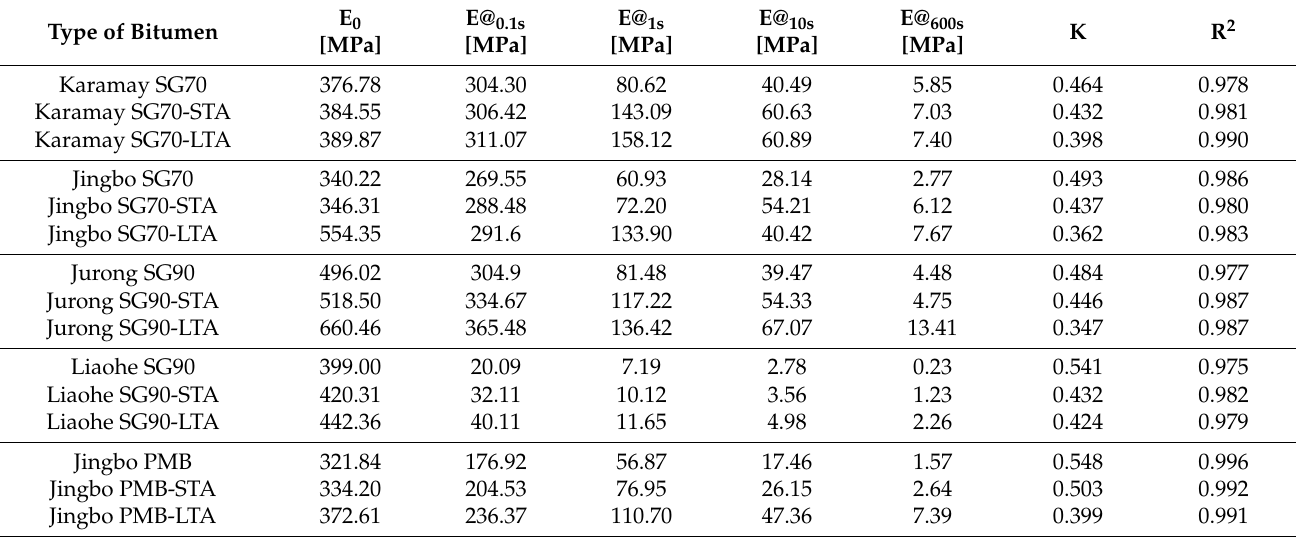
Table 8. Fitting results for the relaxation test at − 25 ◦